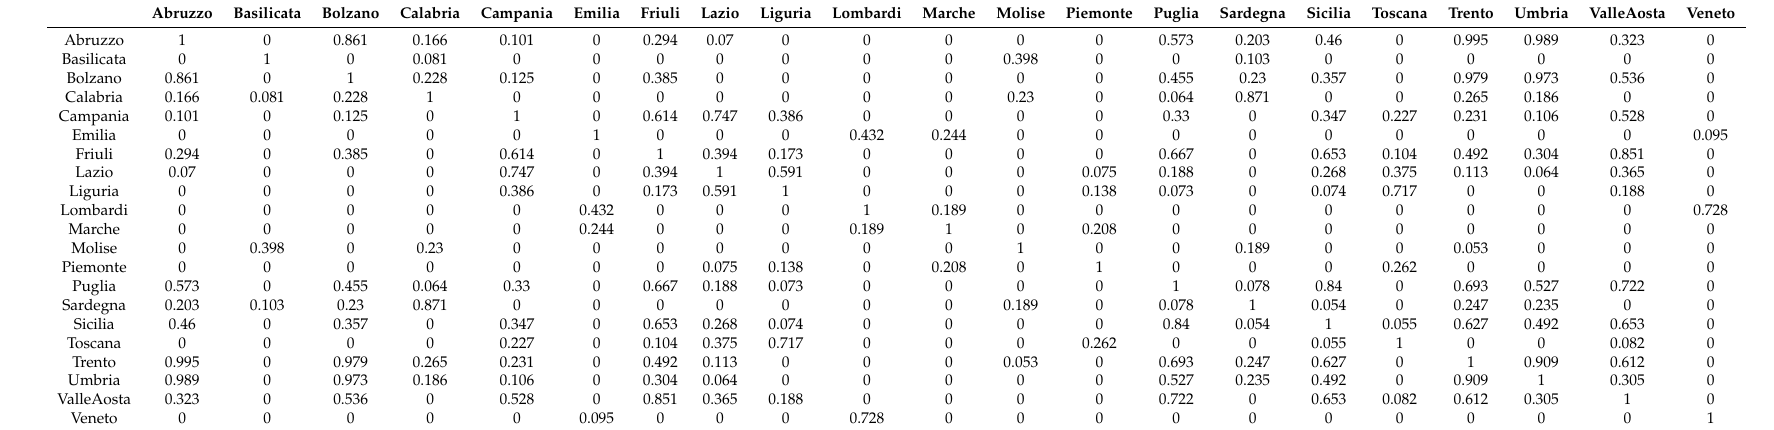
Table A49. Similarity values of Total Cases network in the study period.